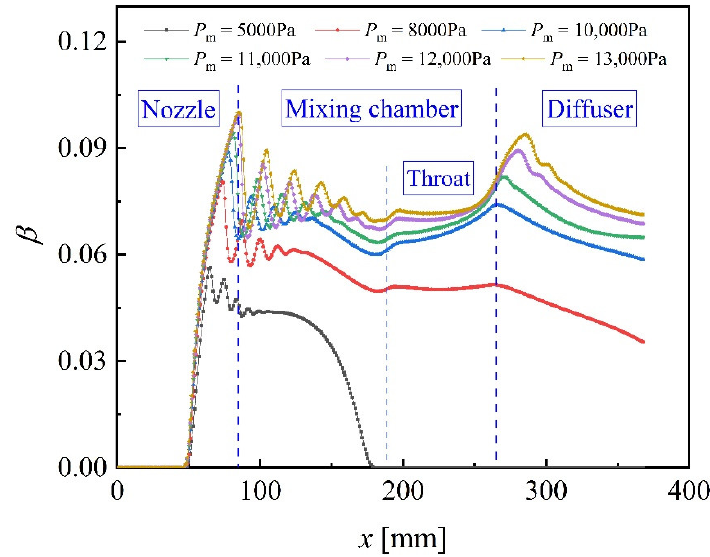
Figure 9. Condensate mass fraction profiles of the axis with different P m .